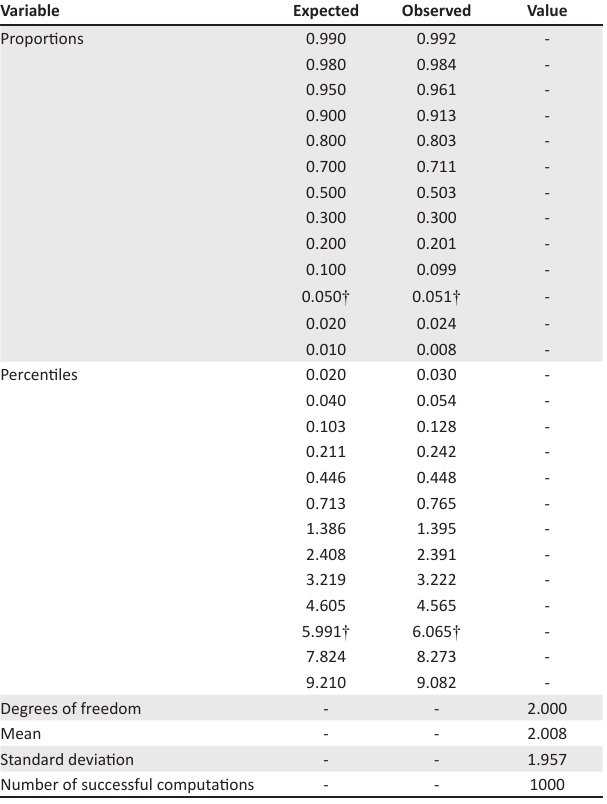
TABLE 8: Mean, standard deviation, critical value of chi-square fit index across 1000 draws.